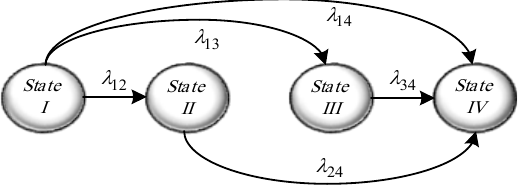
Figure 10. Markov Model for the IFTPVI (the proposed inverter topology).